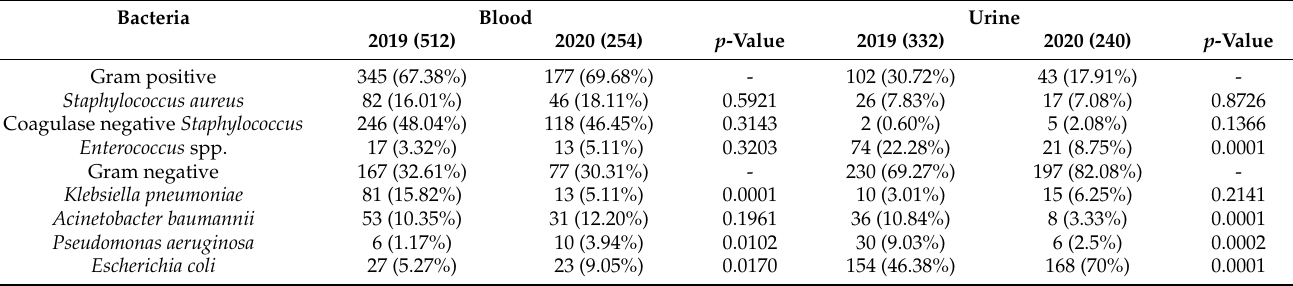
Table 2. Distribution of commonly isolated pathogens from blood and urine samples (2019–2020).